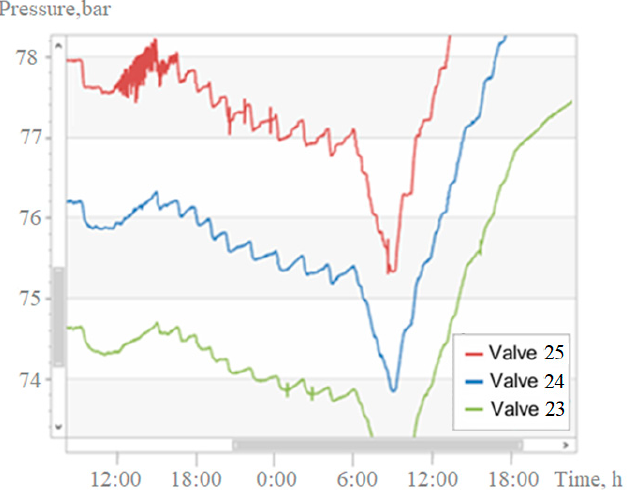
Figure 9. Wave processes recorded by three pressure gauges located at distances of 24 km (between the lower and middle lines) and 28 km (between the middle and upper lines). “Standing” waves. Example 6 (continued).